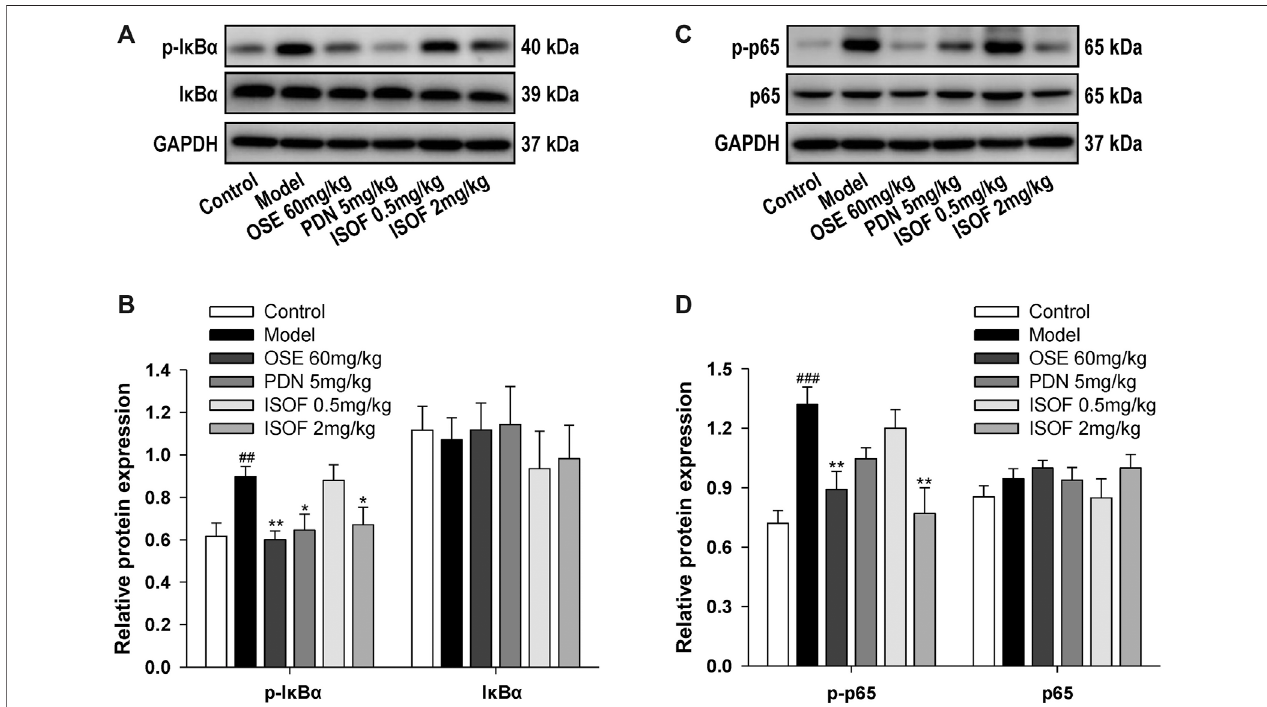
FIGURE 7 | ISOF downregulated NF- κ B signaling pathway activity in the lung tissues of AECOPD model mice. (A) The protein levels of I κ B and p-I κ B in the lung tissuesofeachgroupwereassessedbywesternblot. (B) TherelativedensityofI κ Borp-I κ BtoGAPDHineachgroup. (C) TheproteinlevelsofNF- κ Bandp-NF- κ Binthe lung tissues ofeach group were assessed by western blot. (D) Therelativedensity of NF- κ B or p-NF- κ B toGAPDH ineach group. Dataareexpressed as means ± SEM ( n (cid:1) 4 in each group). ## p < 0.01 and ### p < 0.001 vs. control group; * p < 0.05 and ** p < 0.01 vs. model group.